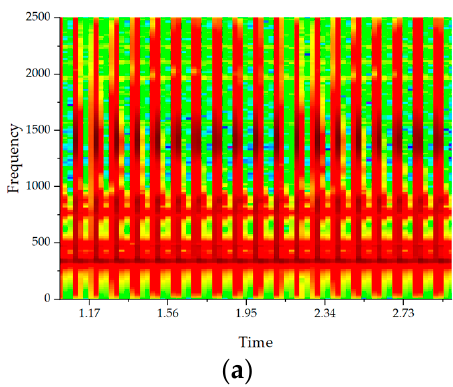
Figure 15. Acceleration response SFFT (Under random variable amplitude amplitude excitation); ( a ) No loosening; ( b ) One bolt loosened to 0.3 kN.